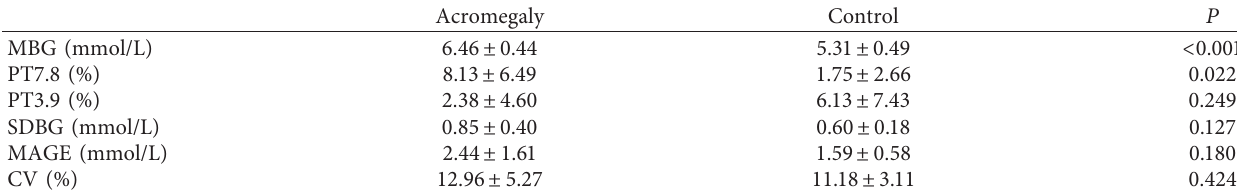
Table 3: The glucose profile and glycemic variability of newly diagnosed acromegalic patients.